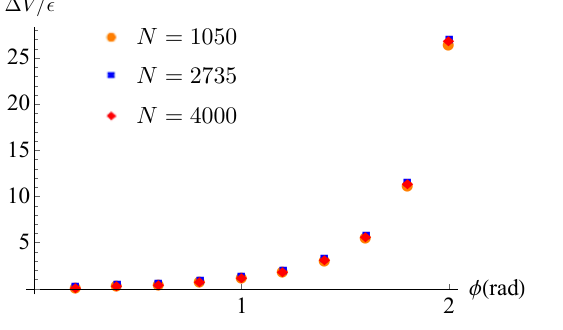
Figure 5 . Plot of (cid:1) V =(cid:15) for N = 1050 ; 2735 ; 4000 with (cid:12)xed ~ T = 0 : 01. They share the same N 2 N; ~ T dependence, as a check of our numerical